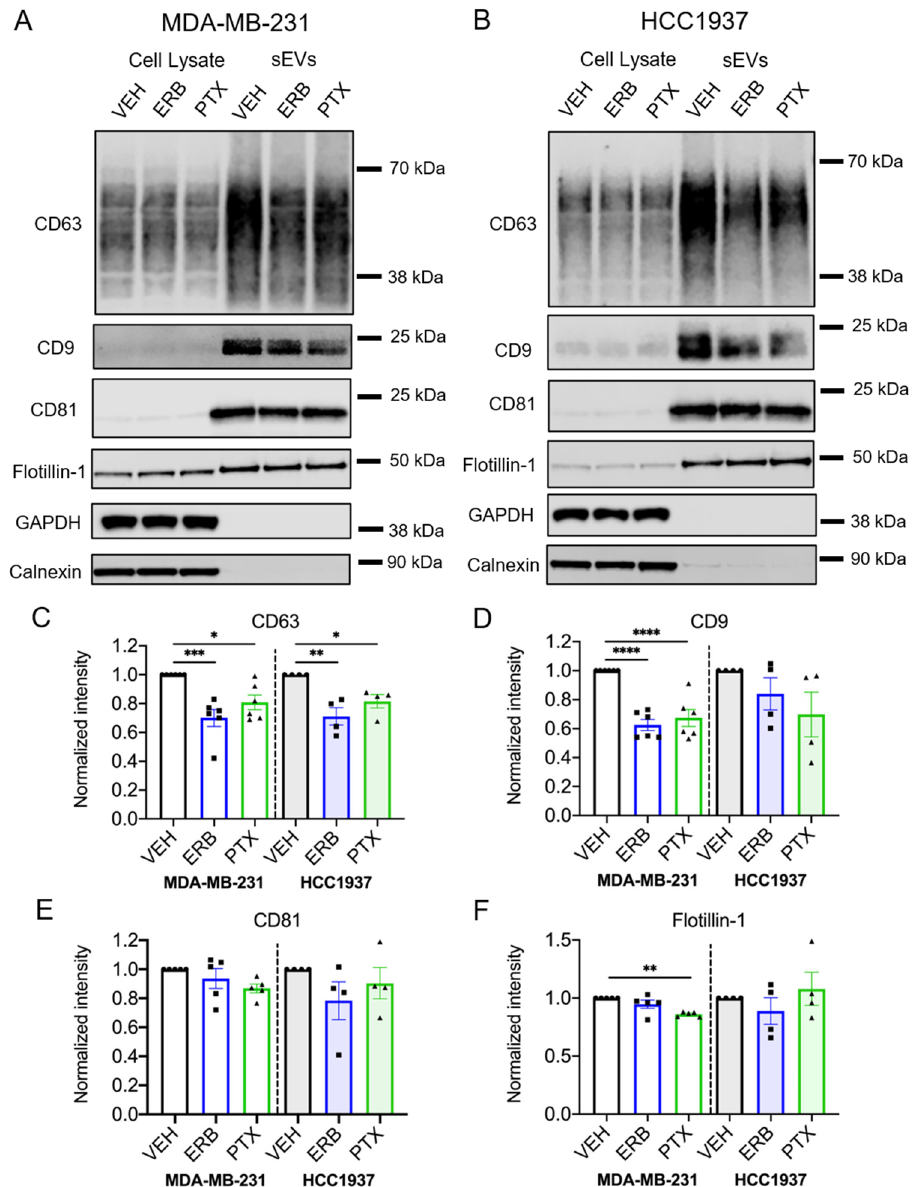
Figure 3. Effects of eribulin and paclitaxel on sEV-associated proteins. MDA-MB-231 and HCC1937 cells were treated for 8 h with vehicle, 25 nM eribulin, or 50 nM paclitaxel and sEVs were isolated from the conditioned media. ( A , B ) Representative immunoblots of indicated proteins in 10 µ g of cell lysates and equal volumes of sEVs representing 7.5% (CD63, CD9, GAPDH) or 42% (calnexin, CD81, flotillin-1) of the yield of 1.2 × 10 8 MDA-MB-231 cells ( A ) or 6–8 × 10 7 HCC1937 cells ( B ). ( C – F ) Band intensities for indicated proteins in sEV samples normalized to vehicle control sEVs. Points represent the results of independent experiments and bars represent the mean ± SEM, n = 4–6. Significance determined by one-way ANOVA with Tukey’s post-hoc. * p < 0.05, ** p < 0.01, *** p < 0.001, **** p <